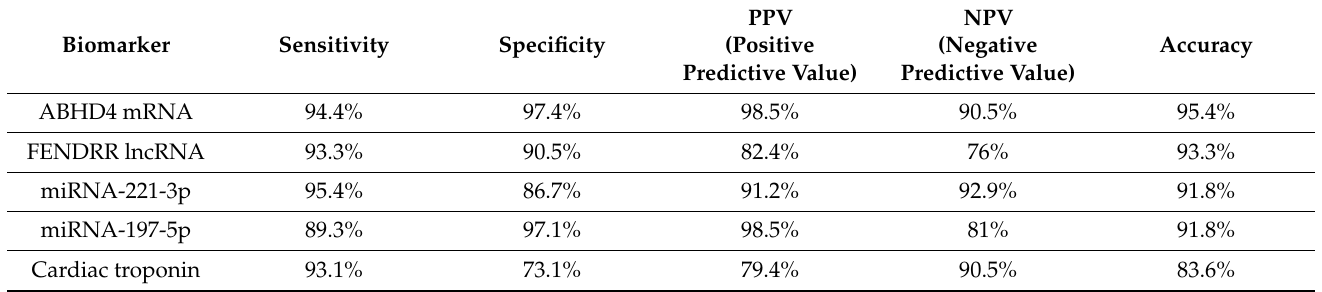
Table 2. Performance characteristics of serum laboratory biomarkers.